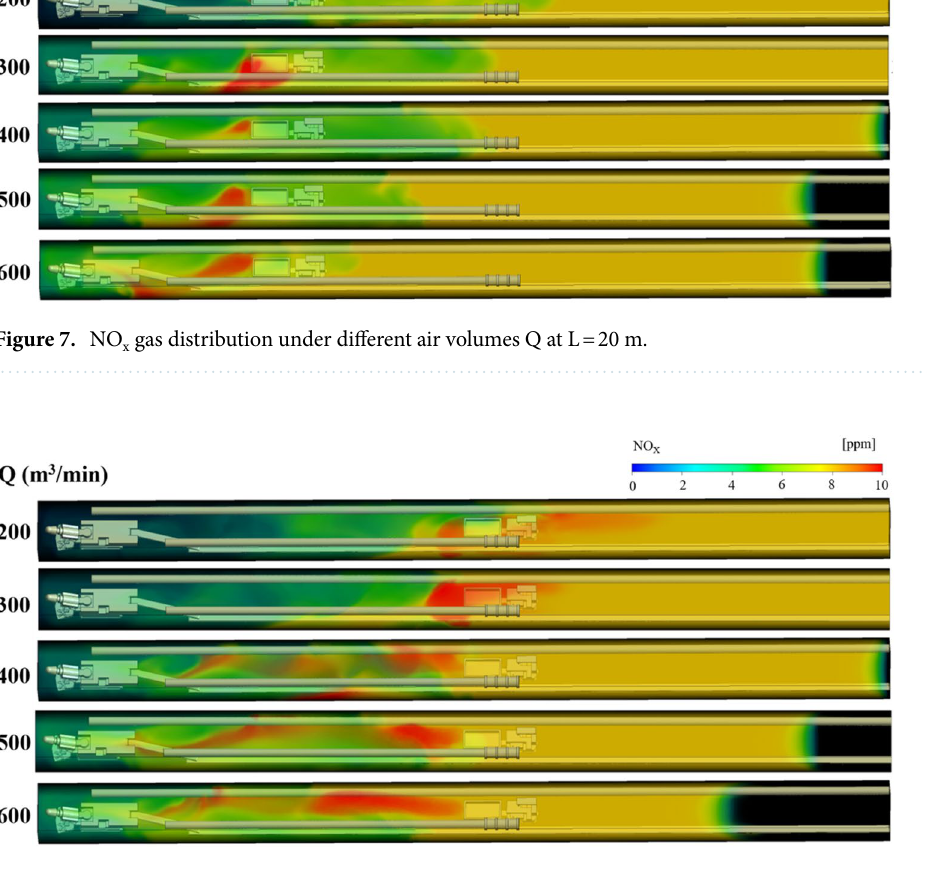
9. The colors of the different regions in the figures indicate the mass fraction of NO x gas in different regions. To facilitate the study of the distribution of NO x gas, the region where the NO x gas mass fraction was greater than 8 ppm was called the high-volume-fraction NO x region (red region in the figures); the region where the mass fraction was between 6 and 8 ppm was called the medium-volume-fraction NO x region (yellow region in the